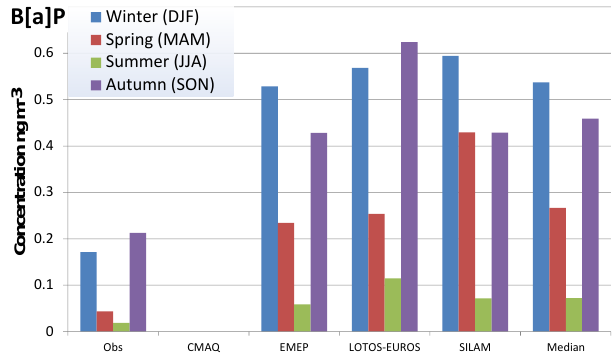
Figure 7. Observed and predicted seasonal concentrations of benso(a)pyrene, mean over the EMEP stations in 2005 (ngm − 3